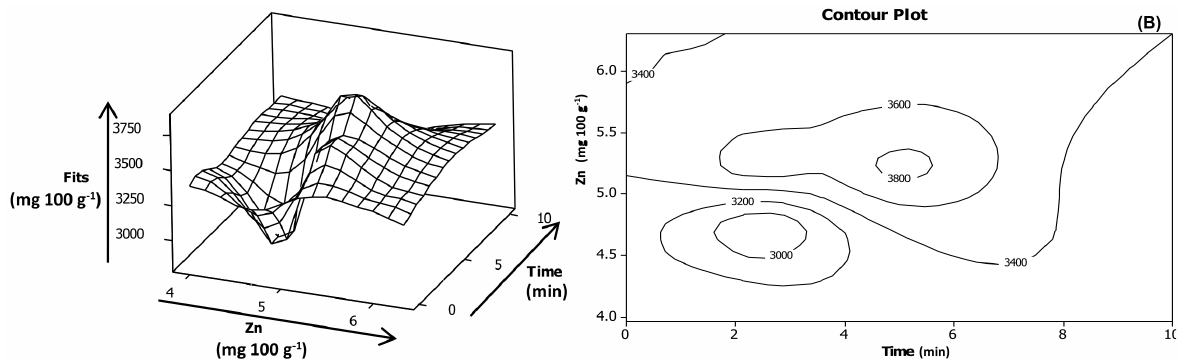
Figure 3. (a) Response surface; (b) Contour plot to study the minimization of the response predicted by the model in relation to the Fe compound and time in